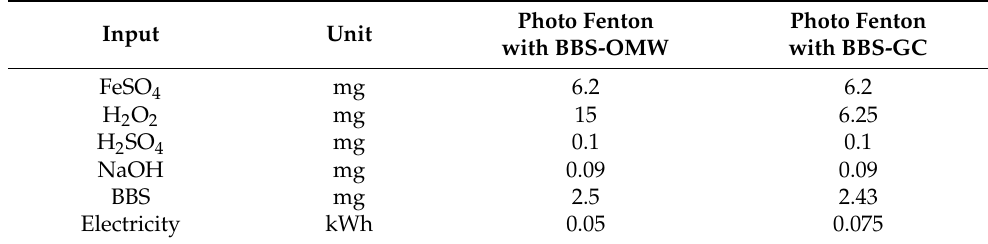
Table 3. Inventory of the input for the treatments of 250 mL of Milli-Q water contaminated with caffeine (5 mg/L), in the presence of different complexing agents: BBS-GC and